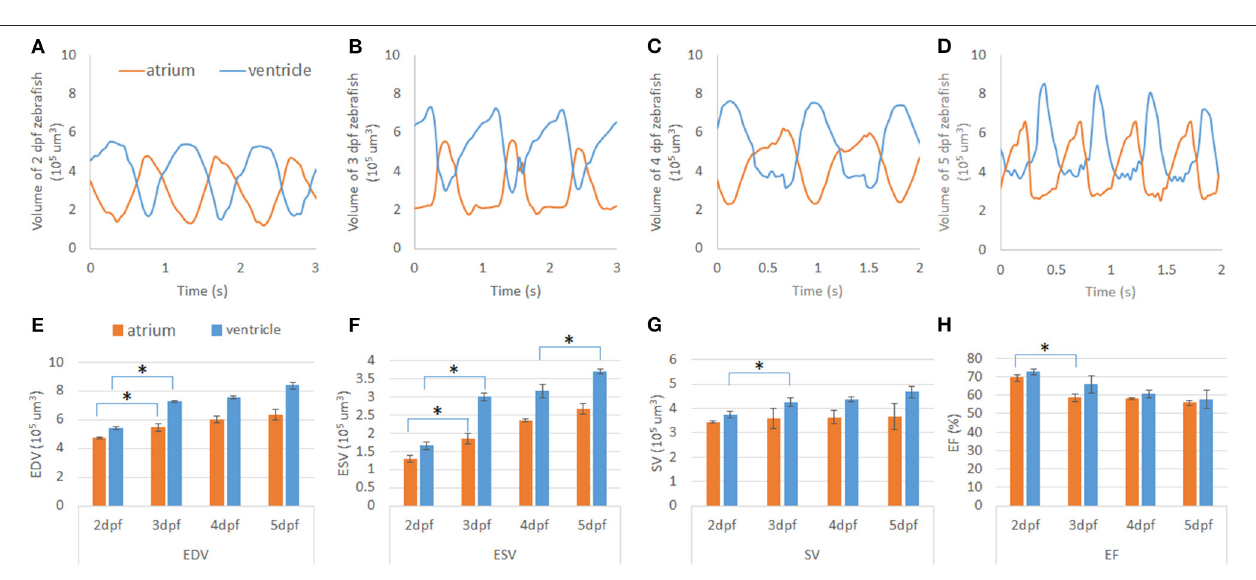
FIGURE 6 | Cardiac mechanics analysis of developing zebrafish heart. (A–D) Volume change of developing zebrafish heart was measured by U-net-based autosegmentation, showing consistent increase in volume in both the atrium and ventricle. (E,F) After notable morphology change after cardiac looping, end-diastolic volume (EDV) and end-systolic volume (ESV) were increased significantly in both the atrium and ventricle. At 5 dpf, ESV was also significantly increased compared to 4 dpf. (G) While SV of the ventricle showed an increasing trend, that if the atrium remained at a similar level from 2 to 5 dpf. (H) Ejection fraction (EF) analysis demonstrated a decreasing trend from high EF at 2 dpf. * p ≤